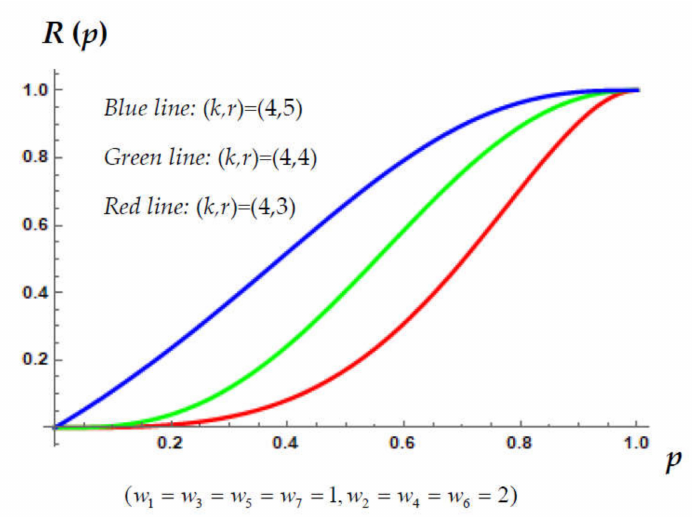
Figure 1. The reliability polynomials weighted- r -within-consecutive-4-out-of- n : F systems of order 7.